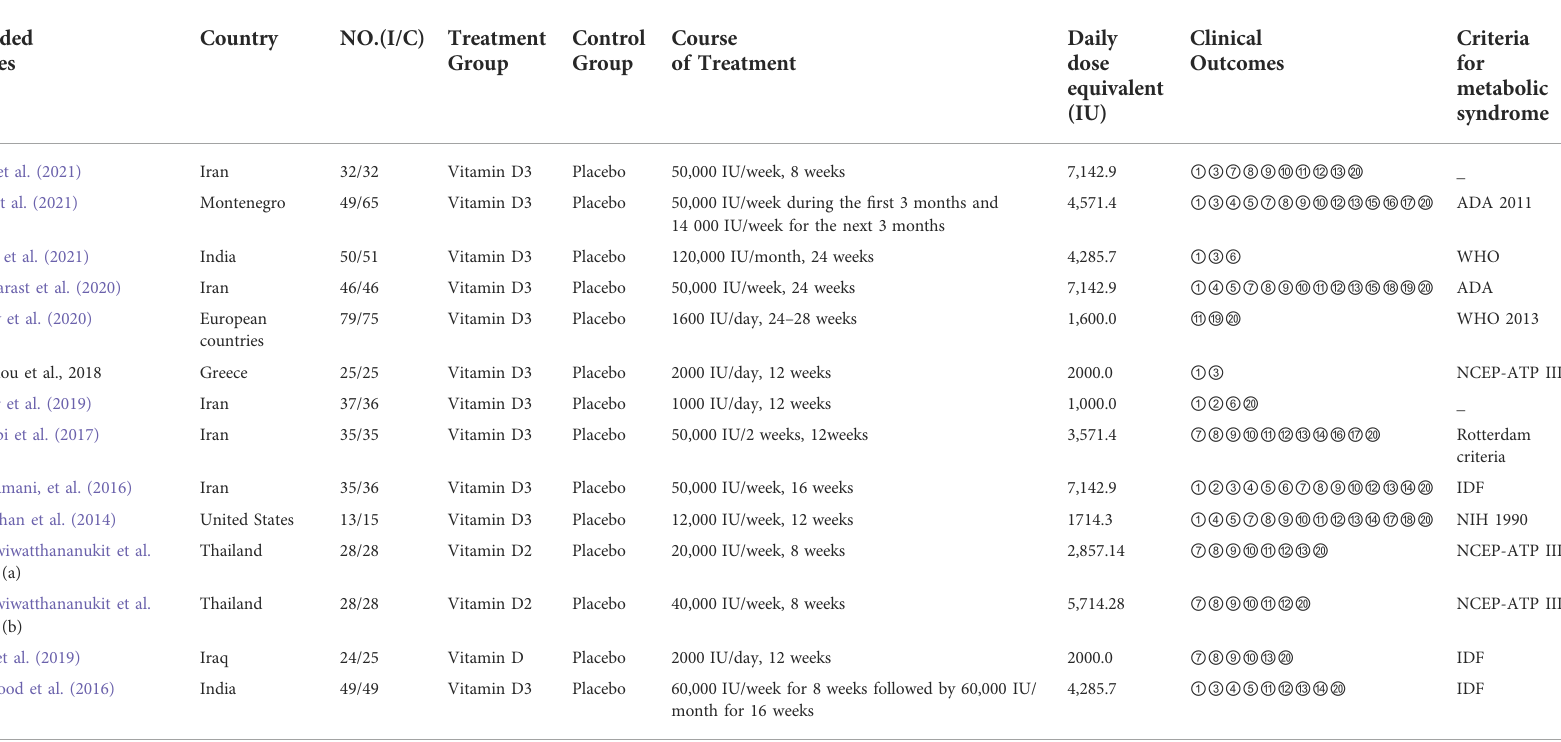
TABLE 1 Information of included